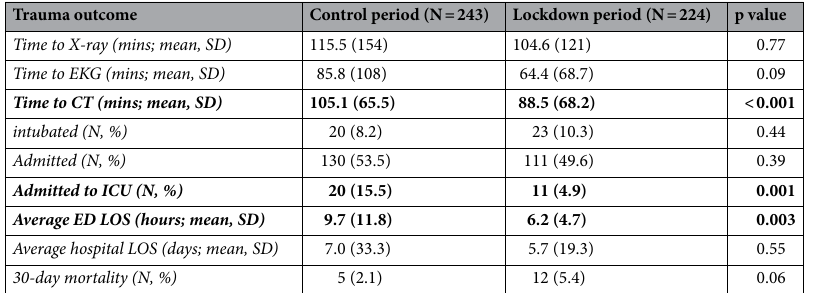
Table 3. Trauma Outcomes of trauma activations during the control and lockdown period. Significant values are in bold. EKG electrocardiogram, CT computed tomography, ICU intensive care unit, LOS length of stay, SD standard